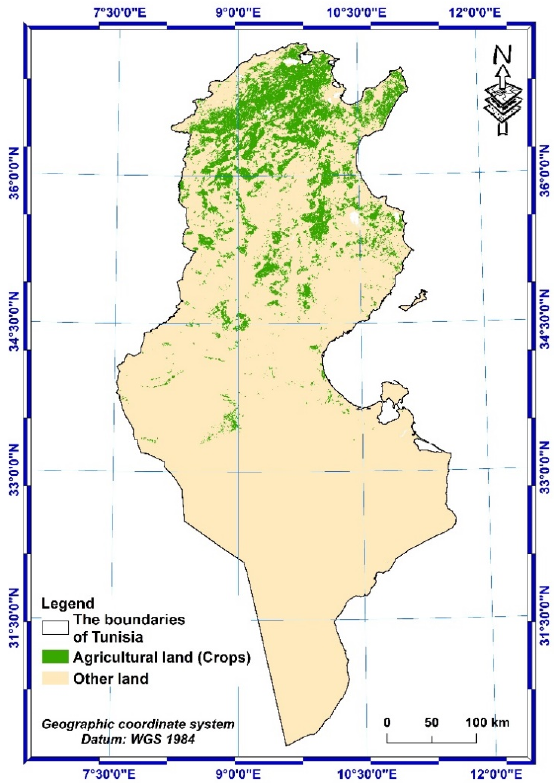
Figure 13. Agricultural and nonagricultural lands in Tunisia.